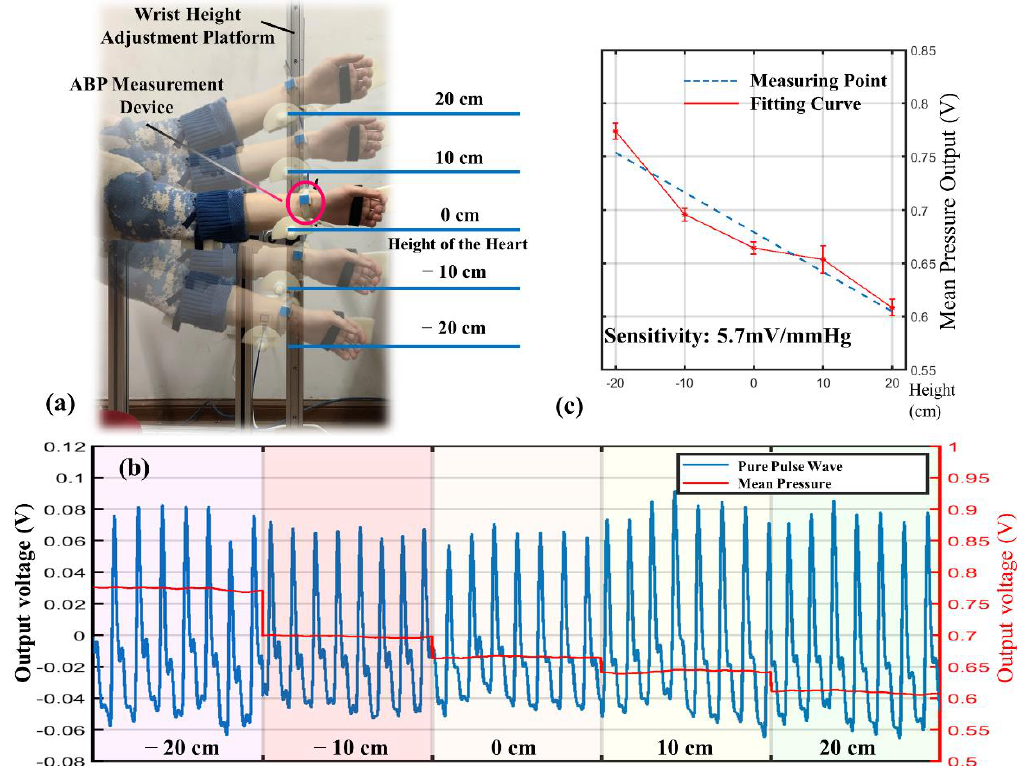
Figure 8. Individualized calibration results. ( a ) Experimental setup for ABP control. ( b ) Pulse signals at different heights. ( c ) Recalibrated sensitivity.